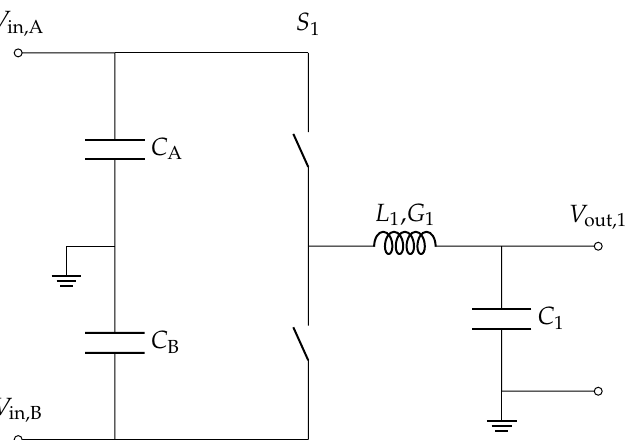
Figure 4. Schematic of the converter with output LC-filter. For testing the components individually in a simple test case, voltage source and resistive load were added at the respective terminals.